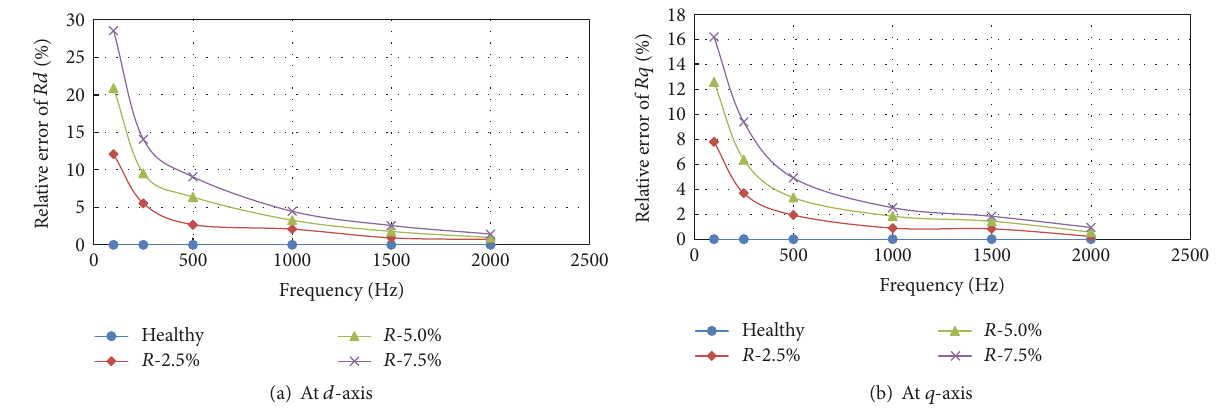
Figure 16: Relative error of measured